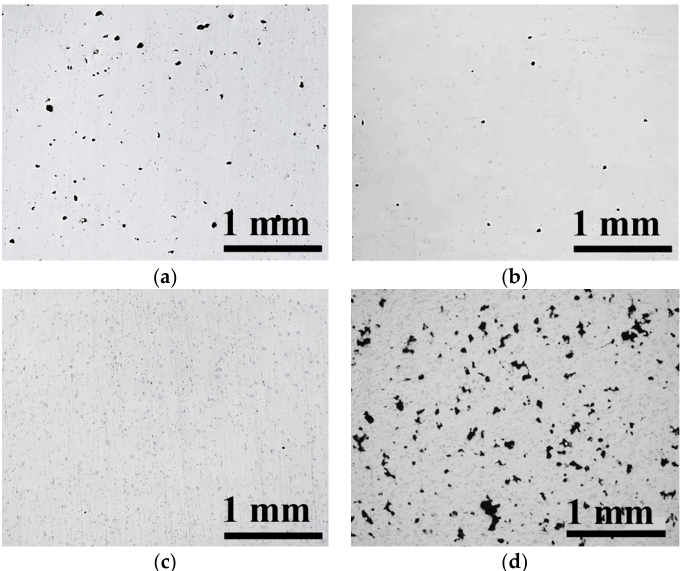
Figure 4. Optical micrograph of cross-sections of LPBF-built Ti-Ta obtained at the four building parameters; ( a ): S1, ( b ): S2, ( c ): S3, ( d ): S4. The low-magnification (70 × ) SEM images of the samples S1, S2, and S3 were shown in Figure 5a–c. Unmelted Ta particles (white particles in the figure) were found in the matrix. The imaging method was used to make statistics of unmelted Ta particles in the matrix. The unmelted Ta particles accounted for 0.7 vol.%, 5.1 vol.%, and 10.3 vol.% in samples S1, S2, and S3 respectively. The amount of the unmelted Ta particles was increasing with